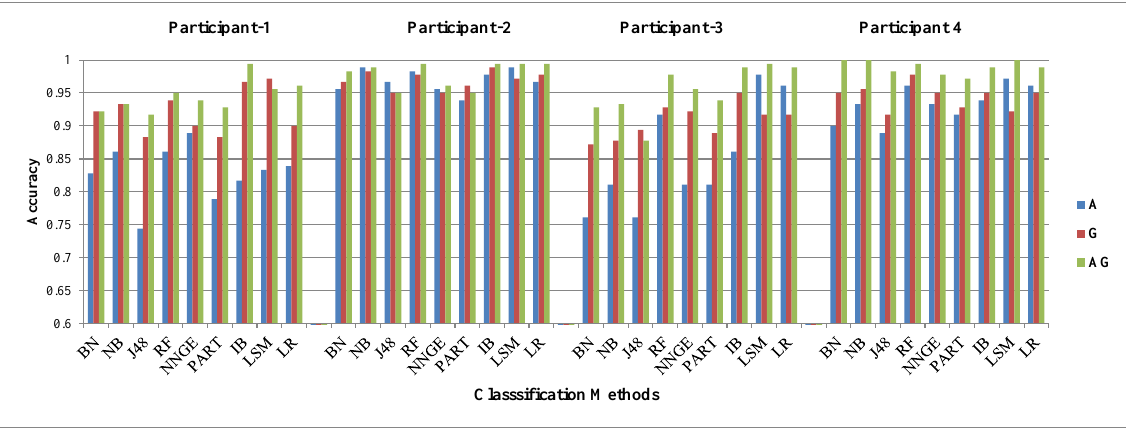
Figure A.9. Recognition performance for the walking upstairs activity in Scenario